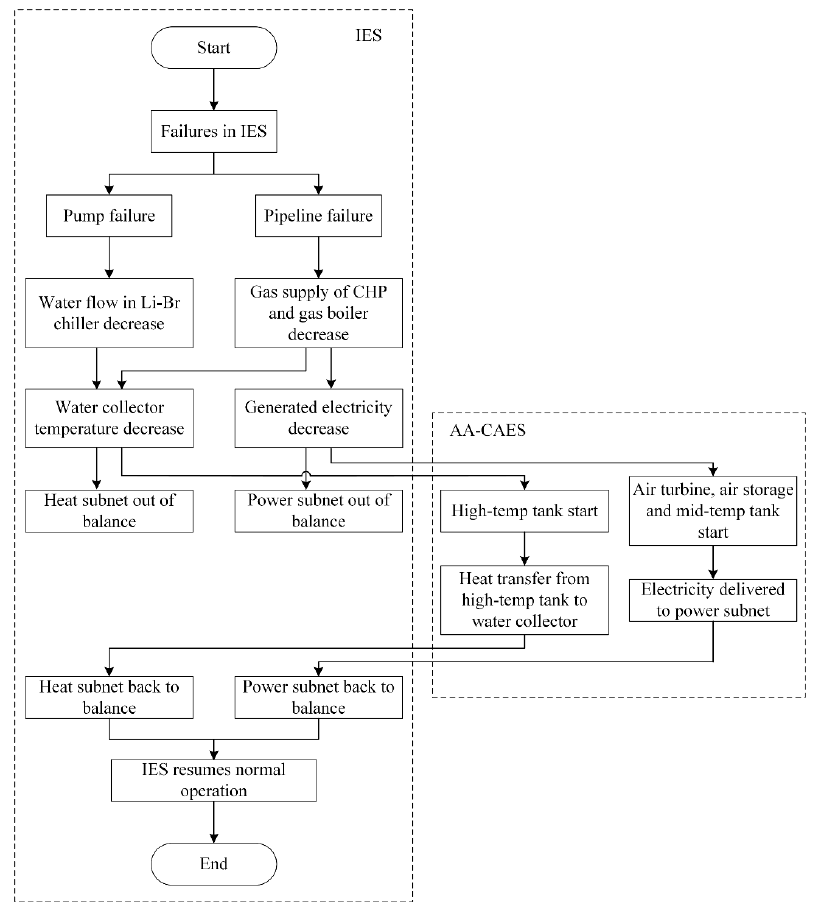
Figure 4. A schematic diagram of robust operation method.